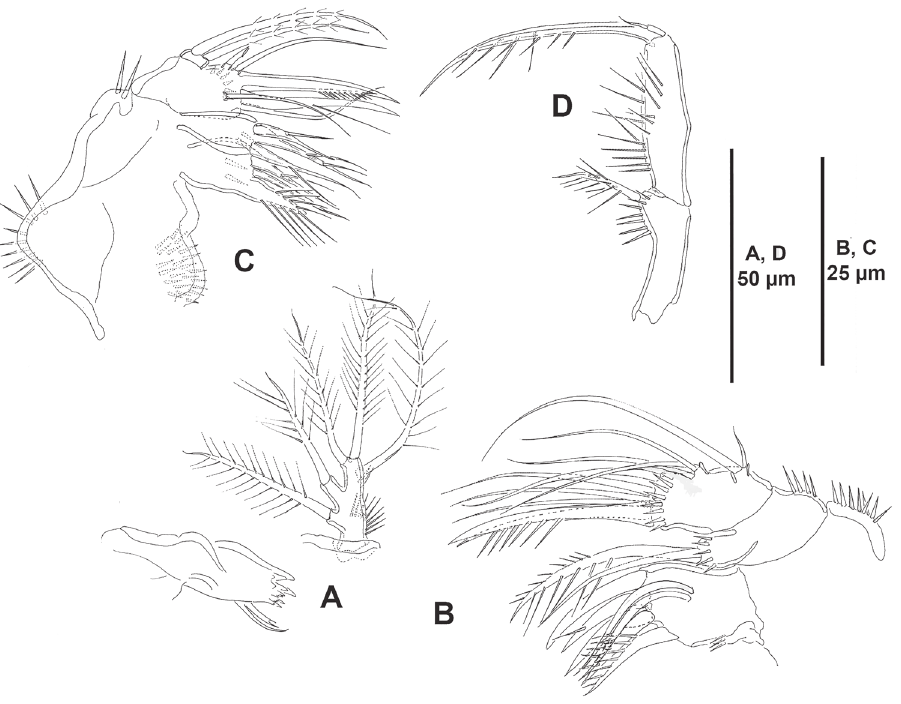
Figure 9. Dendropsyllus californiensis sp. n., female holotype. A mandible, showing detached palp B maxillule C maxilla D